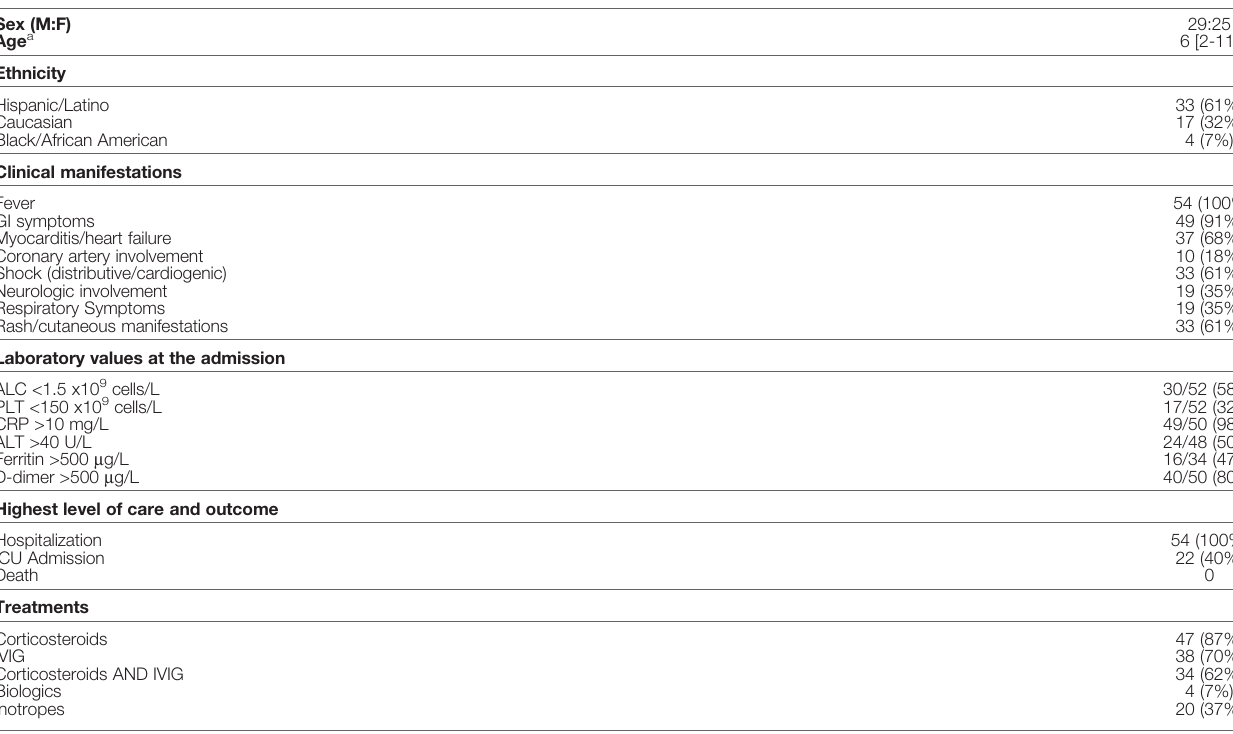
TABLE 2 | Demographics and clinical characteristics of the MIS-C cohort (N =